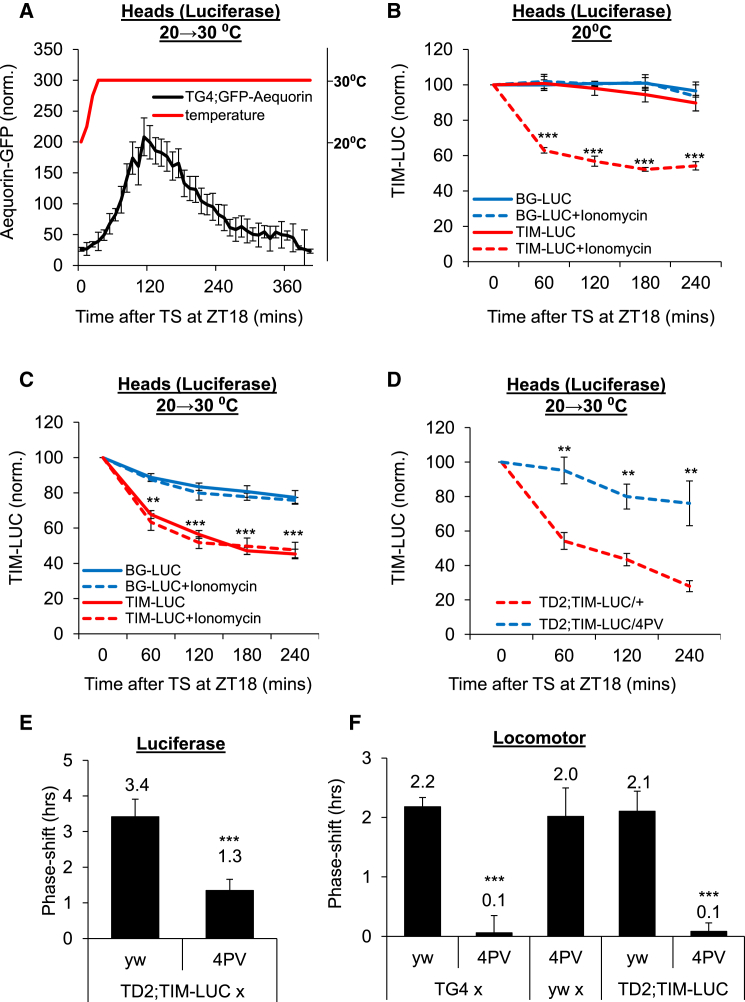
Thermal TIM Degradation Is Dependent on Cytosolic Ca2+(A) A 20°C to 30°C temperature shift (TS) increases intracellular Ca2+ in fly head circadian tissues as measured by luminescence from GFP-Aequorin (n = 72).(B) An ionomycin-induced intracellular Ca2+ increase triggers TIM-LUC (red), but not PER (blue), degradation in isolated heads in culture at 20°C.(C) Simultaneous application of TS and ionomycin has no additive effect on TIM degradation.(D–F) Buffering intracellular Ca2+ in vivo with PV (blue) reduces thermal TIM degradation (D), thermal phase shifts in the periphery (E) and in the brain (F). Both tim-Gal4 (TG4) and tim-GAL4 combined with UAS-dcr2 (TD2) were used to express PV (see the Supplemental Experimental Procedures). Error bars represent SEM for (A)–(D) or SD for (E) and (F). p < 0.01 or p < 0.001 from at least four independent experiments (n ≥ 6 each) is indicated with “∗∗” or “∗∗∗,” respectively.See also Figure S2.